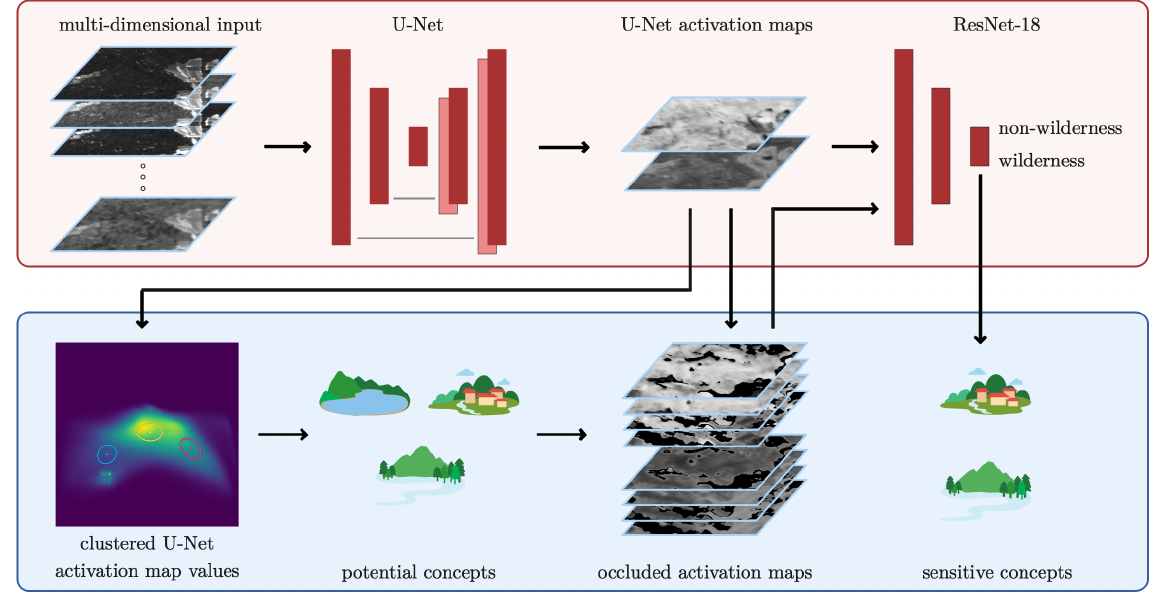
Figure 5. Overview of the jUngle-Net and our methodology. The scene classification pipeline (red box) classifies multi-dimensional images into the classes wilderness or non-wilderness . The interpretation pipeline (blue box) derives potential concepts by clustering U-Net activation maps of correctly classified images. Sensitive concepts belonging to the classes are identified by comparing the confidence scores of the ResNet-18 obtained with non-occluded U-Net activation maps and concept-occluded activation